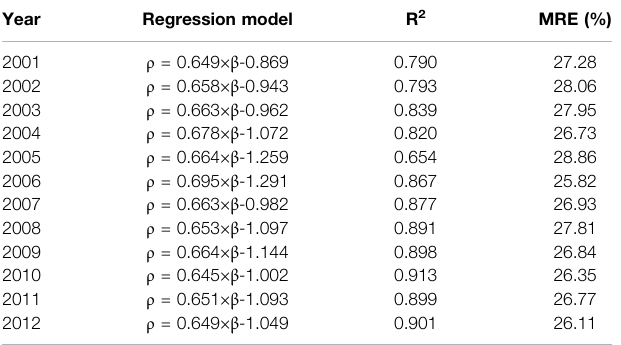
TABLE 2| Non-agricultural GDP spatial model from 2001to2012 ( ρ and β arethe GDP density and Ln values of EAHSI, respectively).